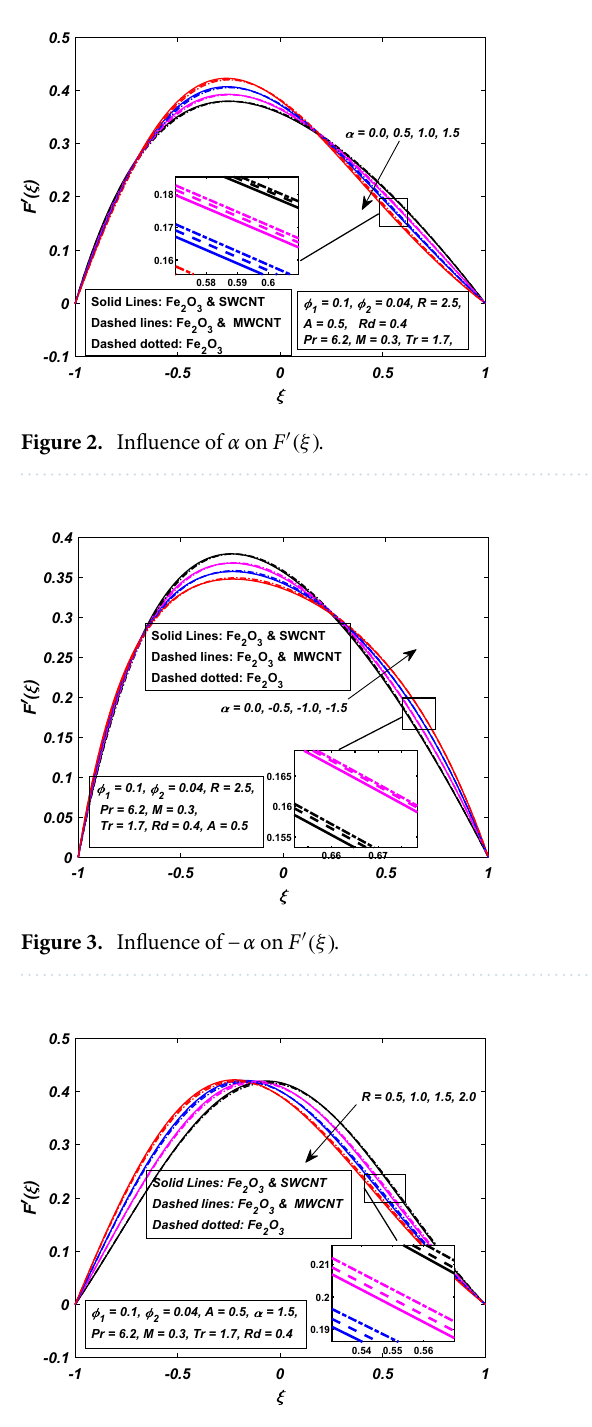
Figure 4. Influence of R on F ′ (ξ)